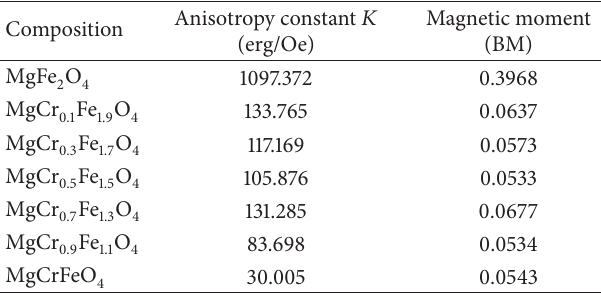
Table 4: Anisotropy constant and magnetic moment values for various Mg-Cr